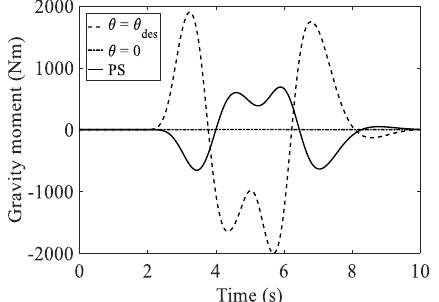
Figure 16. Time-domain response of the vehicle gravity moment.